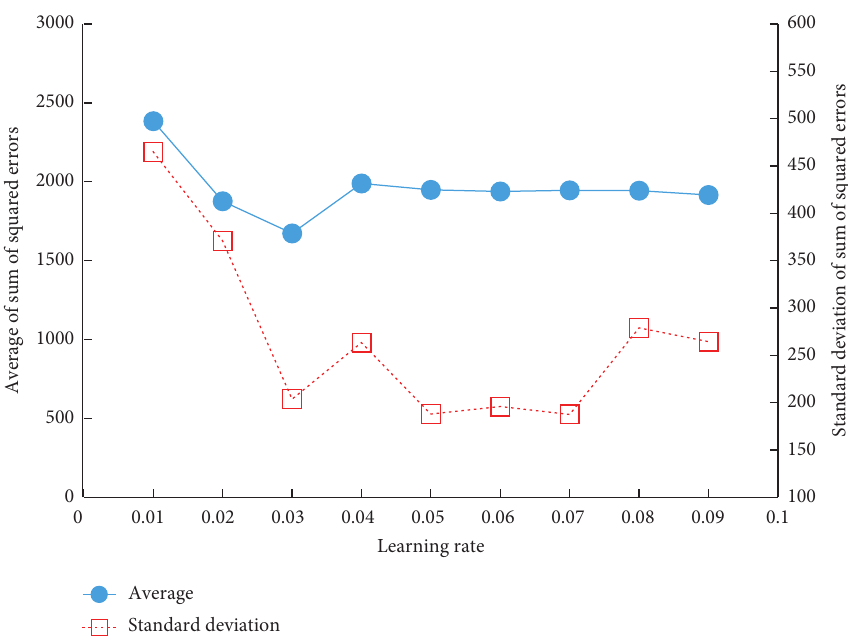
Figure 4: Relationship between sum of squared errors and different learning rate. Table 2: Prediction error for eco-level of driver